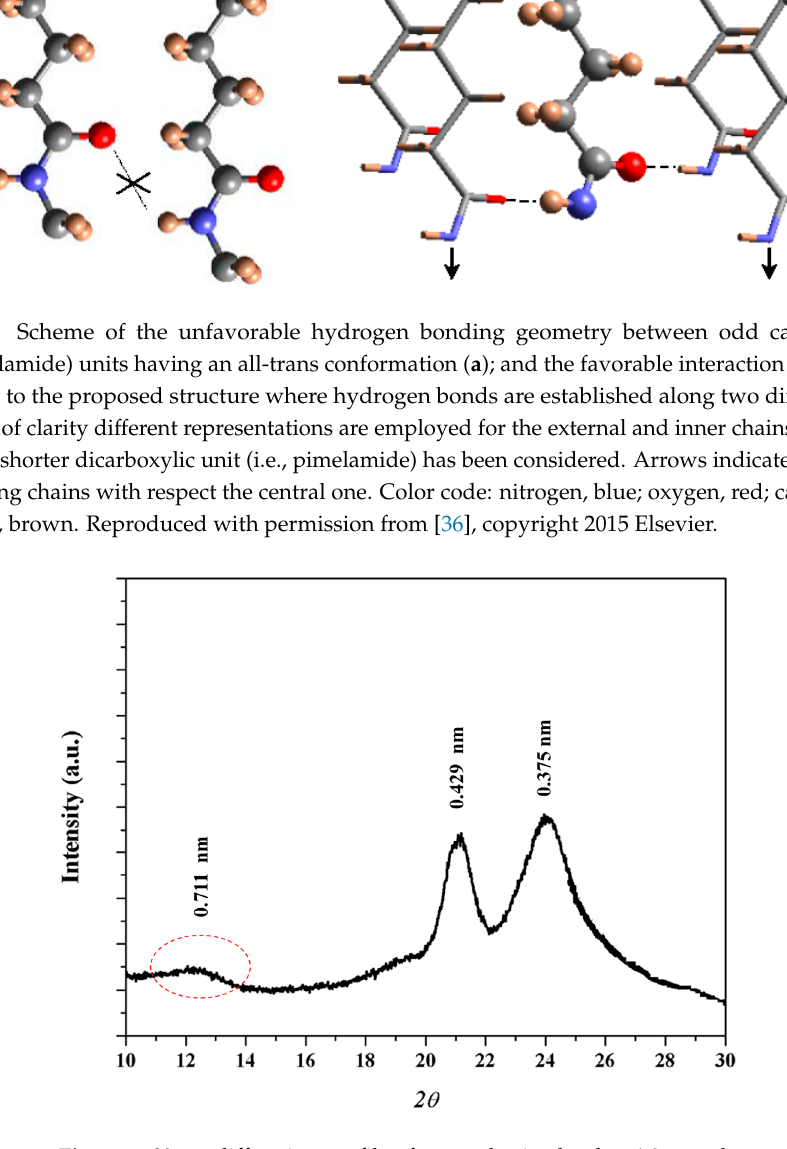
Figure 5. X-ray diffraction profile of as synthesized nylon 4 9 sample.